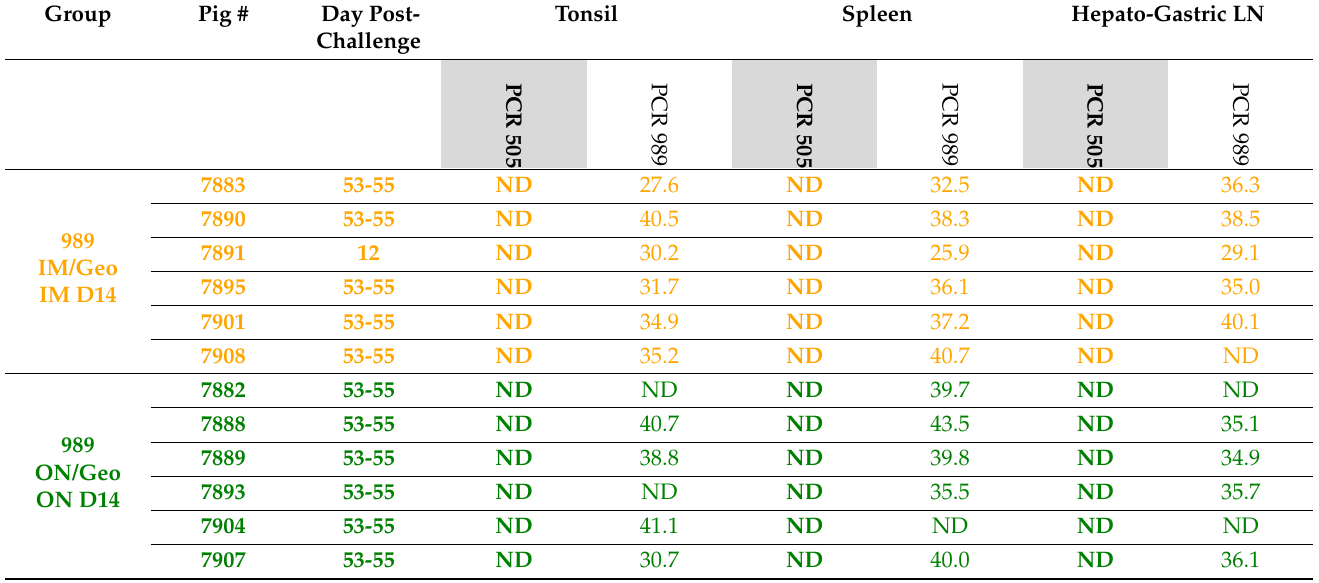
Table 6. Detection of ASFV-989 and Georgia ASFV genome in tissues of immunized pigs challenged with Georgia strain 14 days after